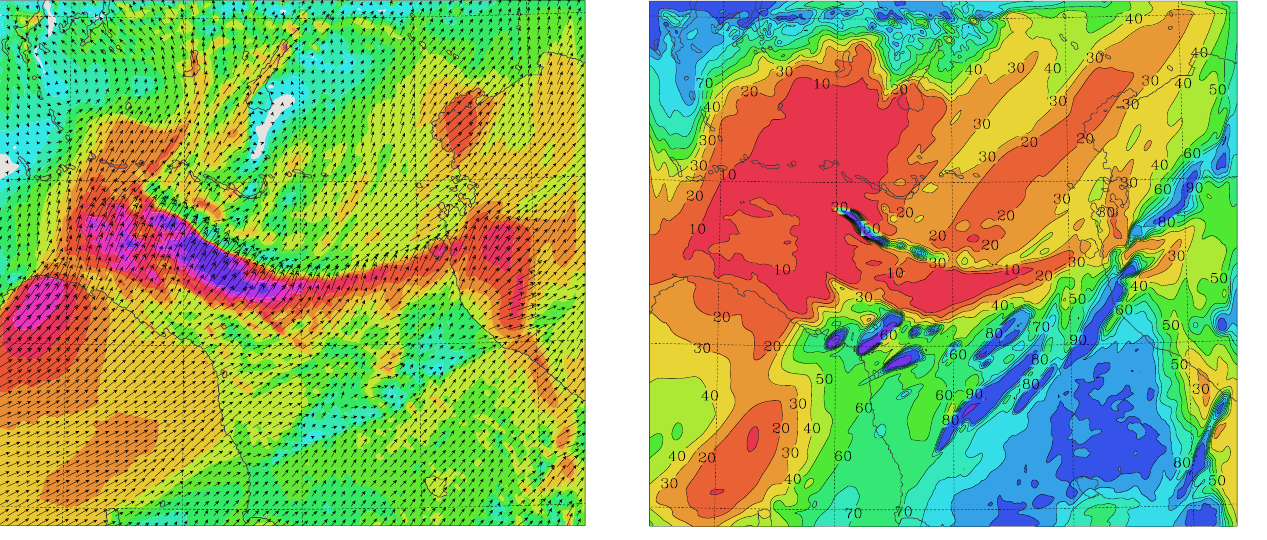
Fig. 6. Wind vectors at 10 m at 09:30 UT, with contours of wind speed, interval 2ms − 1 .